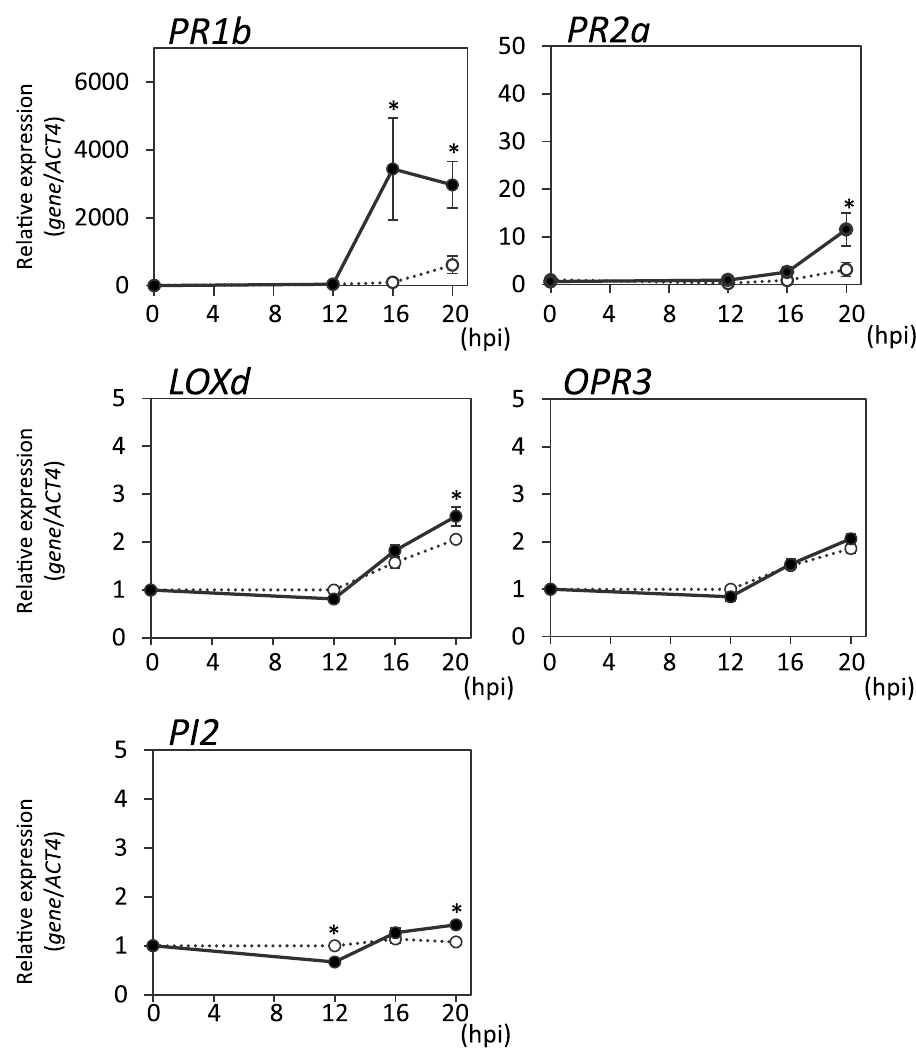
Figure 3. Expression of defense-related genes after infection with the virulent pathogen. The G. margarita - colonized (14 days after G. margarita inoculation) and the water-treated control tomato plants were inoculated with Pst . Leaf disks were taken from the Pst -infiltrated part of the leaflets at the indicated time points (0, 12, 16, 20 h post inoculation (hpi)) and used for gene expression analyses of SA-related genes ( PR1b and PR2a ) and JA-related genes ( LOXd, OPR3 and PI2 ). Transcript levels were normalized to the expression of ACT4 measured in the same samples. The means and SEs were calculated from 4 independent samples, each prepared from a single plant. Open circle, water-treated control plant; closed circle, G. margarita -colonized plants. Asterisks indicate statistically significant difference between data of the water-treated control and G. margarita -colonized plants (two-sided t-test, p < 0.05). The experiment was repeated three times with similar